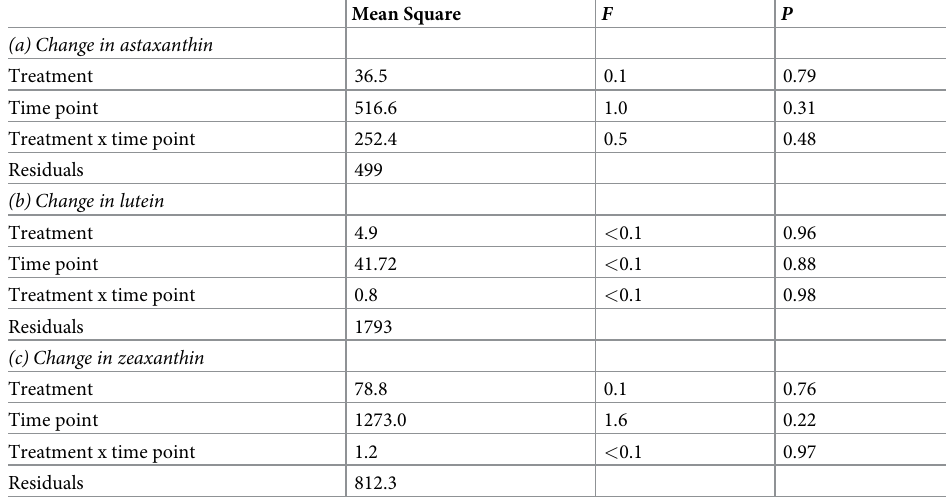
Table 2. The effects of treatment, time point of infection/sampling and their interaction on (a) proportional changes in astaxanthin, (b) lutein and (c) zeaxanthin tested with a multivariate analysis of variance (MANOVA). Proportional changes are the difference between carotenoid contents in eggs and embryos divided by the carotenoid content in